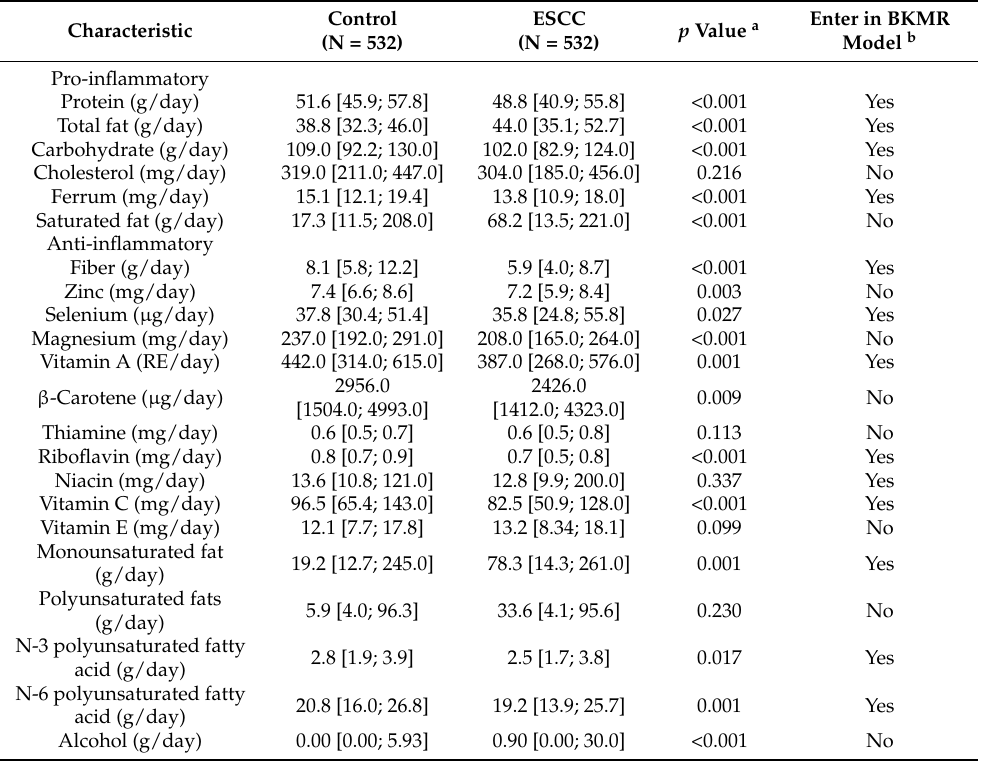
Table 2. Distribution of Nutrient Content Specific for DII in 1064 Subjects among Cases and Controls [Median (IQR)].